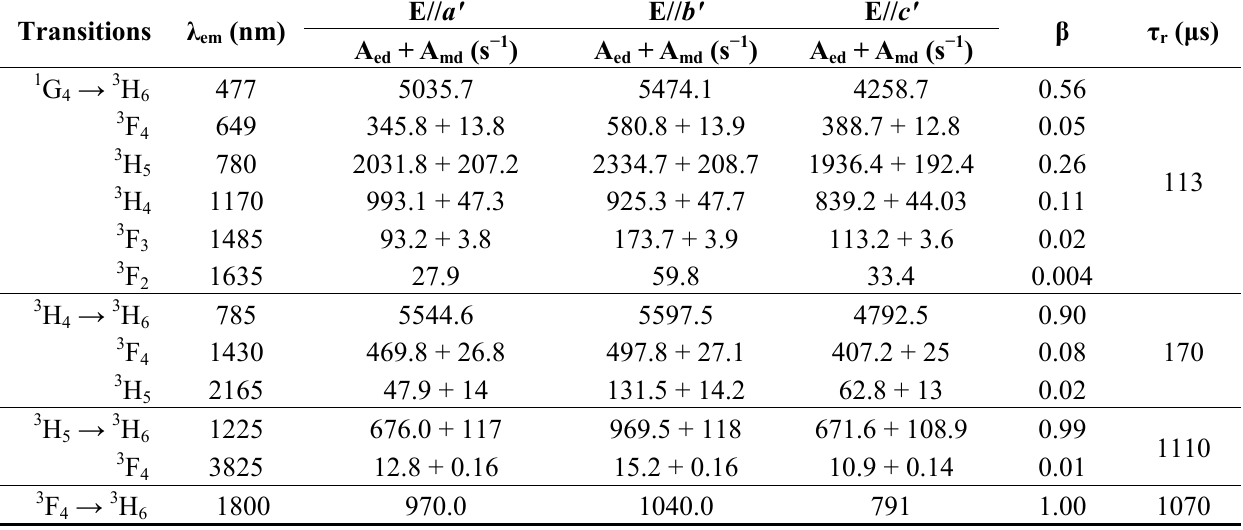
Table 1. The spontaneous emission probabilities, fluorescence branching ratios